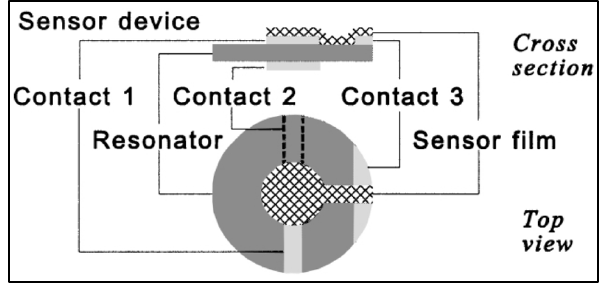
Figure 18. Schematic of a nanobalance gas sensor with selective film [30] (copyright 2001 by the Elsevier Science Ltd).